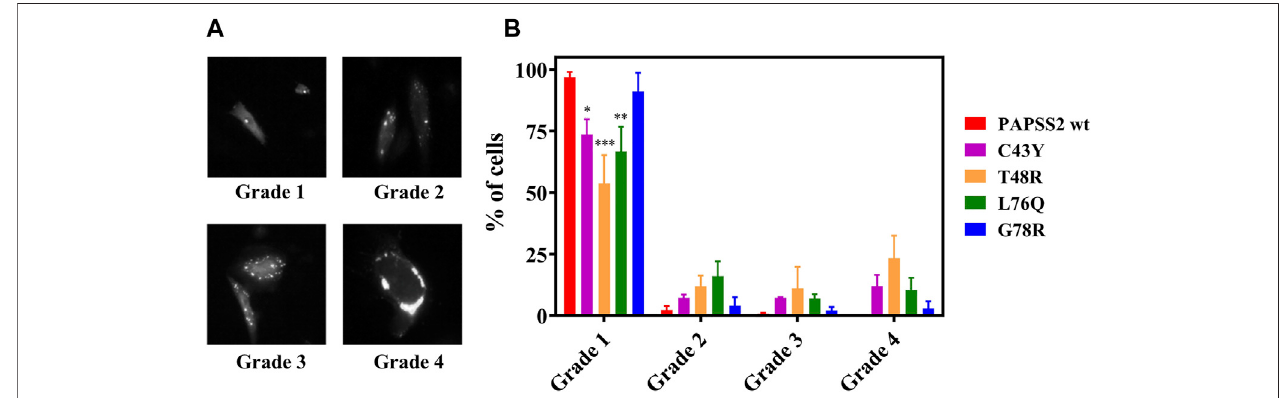
FIGURE4 | Expressionand distribution ofrecombinanthuman PAPSS in HEK293 cells. (A) Exemplary fl uorescence image of HEK293 cells showing fl uorescence spots classi fi edaccordingtothree categories. (B) Evendistribution;nospeckles: grade1,1 – 3speckles:grade2,4 – 10speckles:grade 3and morethan 10specklesor large clumps: grade 4. Data is presented as average ± s.e.m. Cells were counted from four different slides ( N = 4) with n > 200 cells in total for each protein variant. Asterisks indicate signi fi cant differences of the fraction of cells showing no speckles compared to PAPSS2 wt (* p < 0.05, *** p < 0.001). Additional statistical signi fi cance within grade 1 was found between G78R and T48R(***) or G78R and